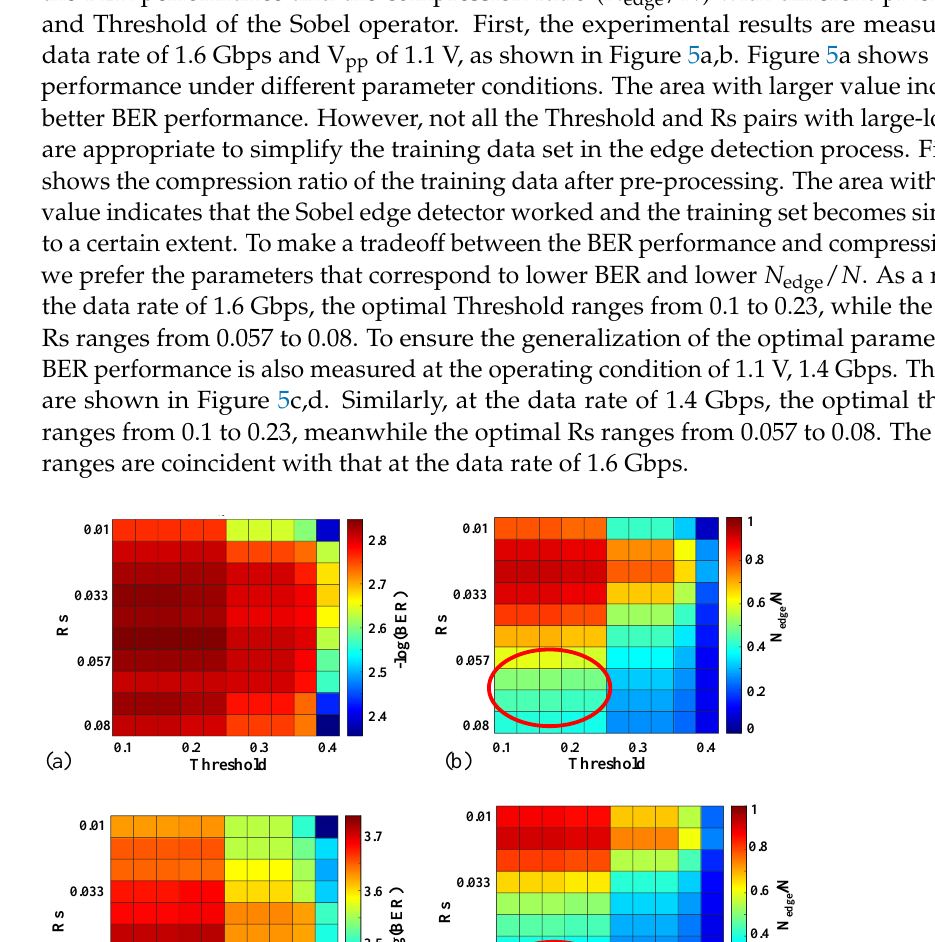
Figure 5. Parameter selection based on grid search. ( a ) BER performance, and ( b ) at 1.6 Gbps. ( c ) BER performance, and ( d ) at 1.4